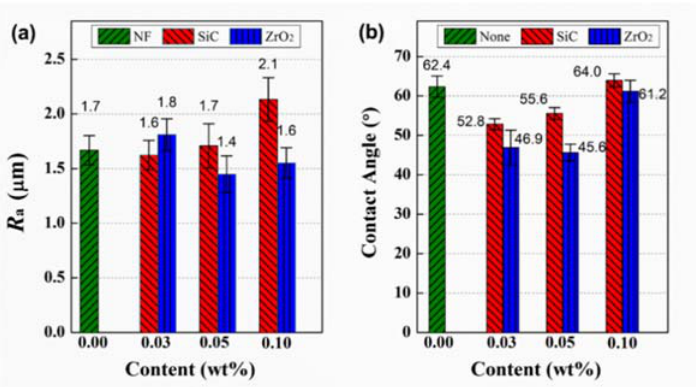
Figure 3. ( a ) The surface roughness R a and ( b ) water contact angle of the surface of enamel coatings with SiC / ZrO 2 fillers.